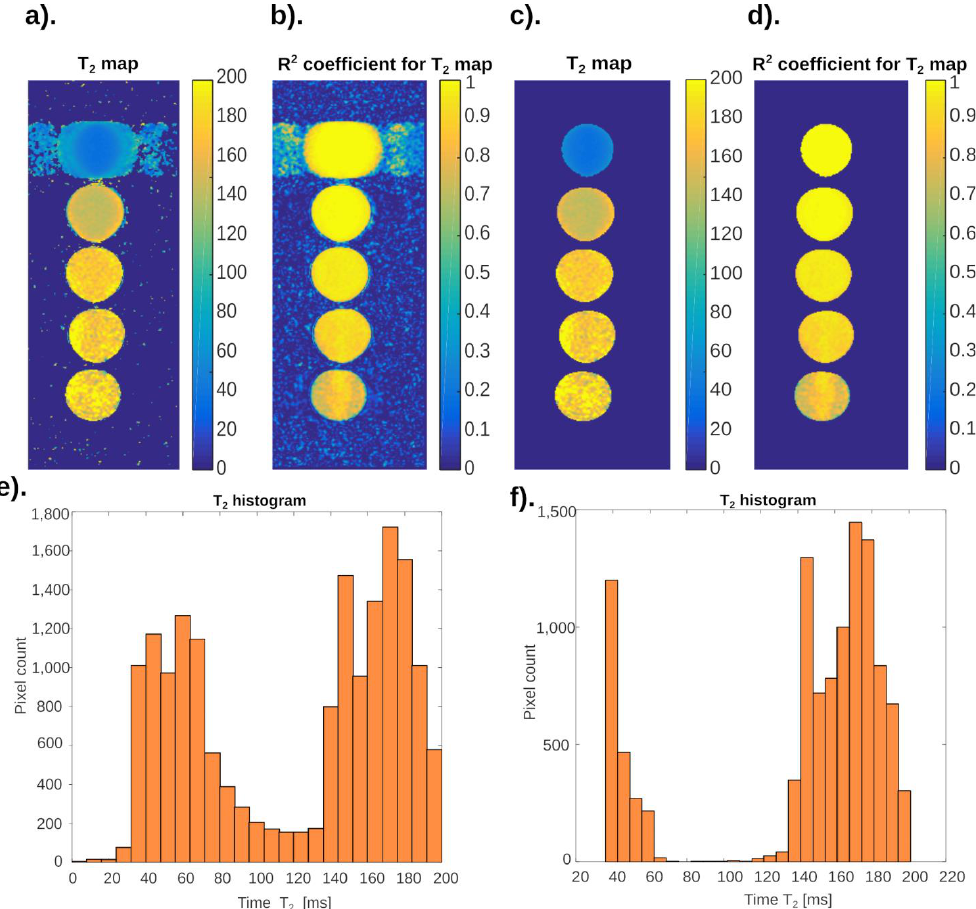
Figure 4. Distribution of T 2 time values for the tested phantom, the color of each pixel corresponds to the value of the longitudinal relaxation time that was measured for a specific pixel in a series of DICOM images: (a) phantom maps showing the distribution of T 2 times before the neural network analysis; ( b ) phantom maps showing the distribution of fit coefficient R 2 values before the neural network analysis; ( c ) phantom maps showing the distribution of T 2 times after the neural network analysis; ( d ) phantom maps showing the distribution of fit coefficient R 2 values after the neural network analysis; ( e ) histograms of longitudinal relaxation times from images before the neural network analysis; ( f ) histograms of longitudinal relaxation times from images after the neural network